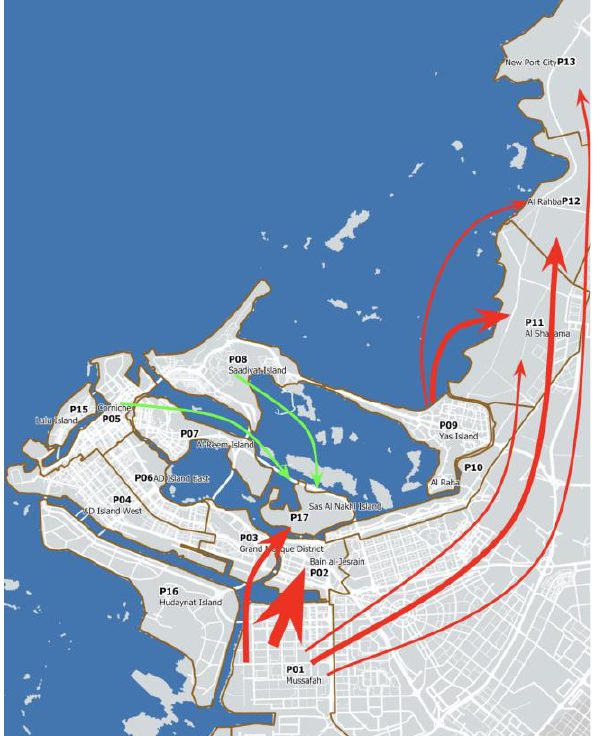
Figure 9. Map of the major hydrodynamic interactions from Table 1. Red arrows indicate protecting the origin precinct will increase the inundated area in the pointed precinct. Green arrows indicate protecting the origin precinct will decrease the inundated area in the pointed precinct. The thickness of the arrow represents the magnitude of the impact (by percentage).